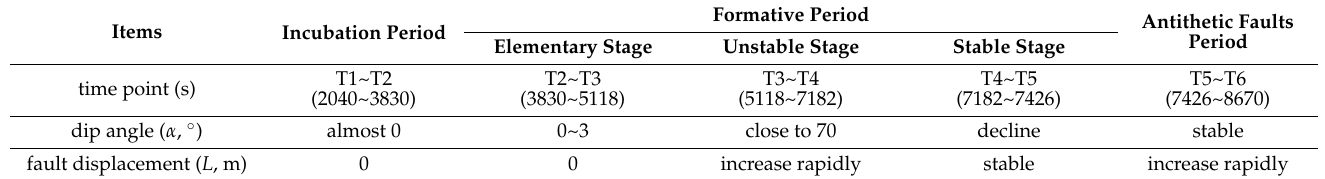
Table 4. The dividing basis of the formation and evolution of normal fault